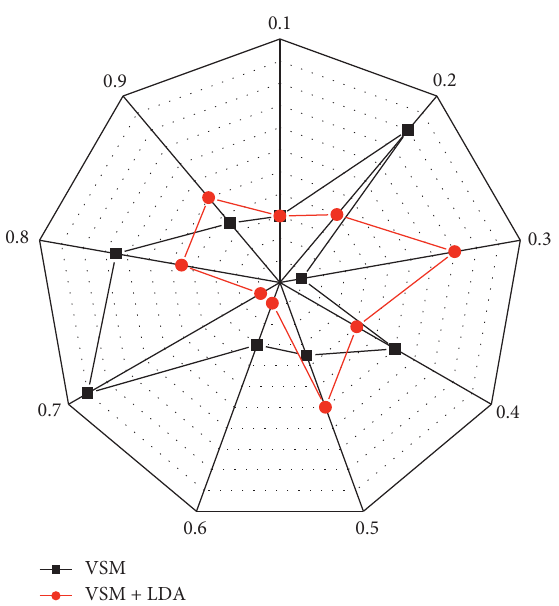
Figure 5: Effect of varying λ values on the root mean square error of the scores.